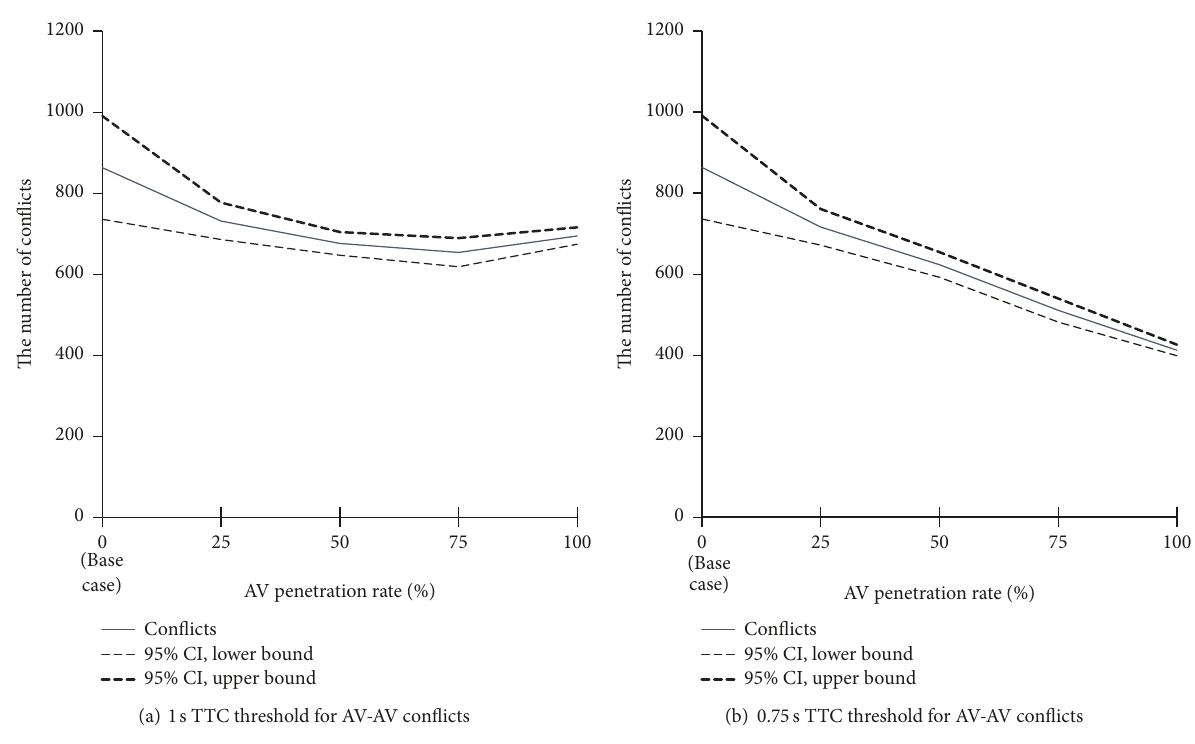
Figure 6: Total number of conflicts by AV penetration rate for the signalised intersection (AV-1 parameters). Table 3: Conflicts by types and AV penetration rates for the roundabout (AV-1 parameters and 0.75 s TTC threshold for AV-AV conflicts). Penetration rate